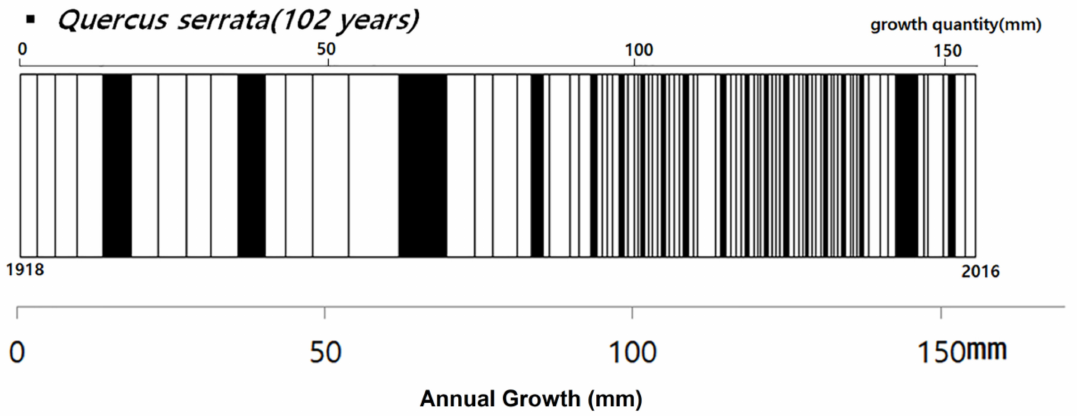
Figure 3. Tree age and growth of the Quercus serrata sample tree in fixed survey plot no. 7 in the forest of the Changdeokgung Rear Garden. Black line in the figure shows the annual rings of the late